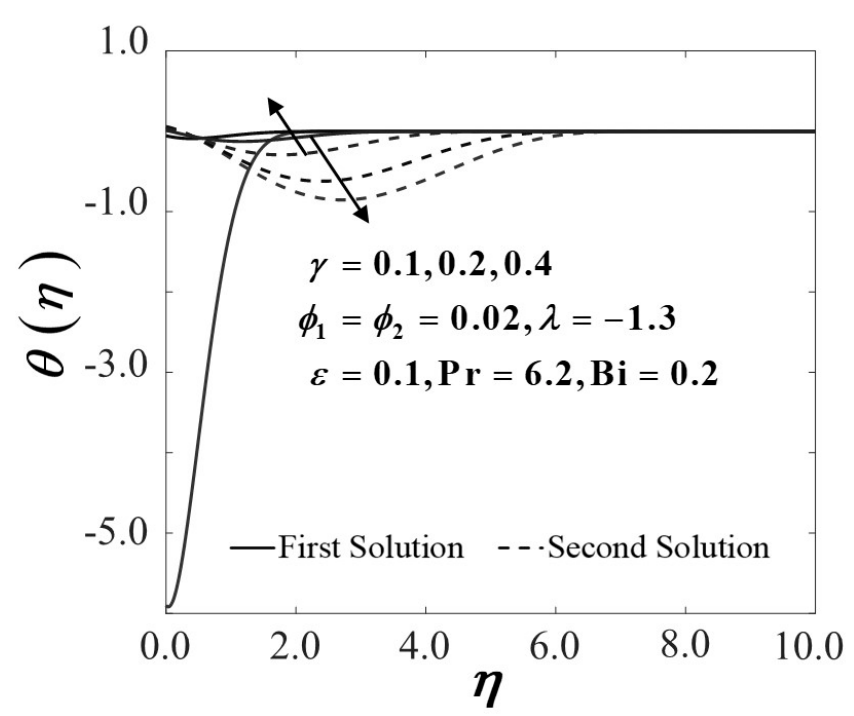
Figure 4. Velocity profiles of